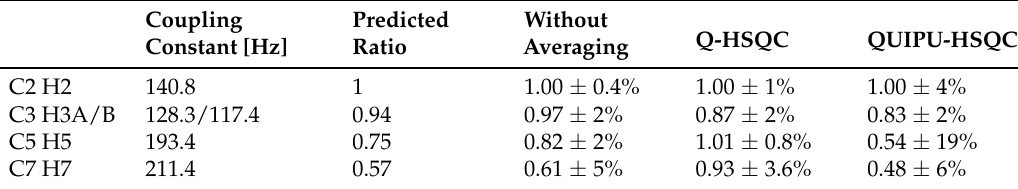
Table 1. Integral volumes of the four histidine signals normalized to C2H2. The third column shows the predicted ratios modulated by non-uniform magnetization transfer due to different J CH values. The predicted ratios were calculated on the basis of in-house measured J CH values. The fourth column presents the measured ratios for the highest histidine concentration measured by standard HSQC without correction by calibration factors. The penultimate and ultimate columns show the observed ratios for the highest histidine concentration observed by Q-HSQC and QUIPU-HSQC,